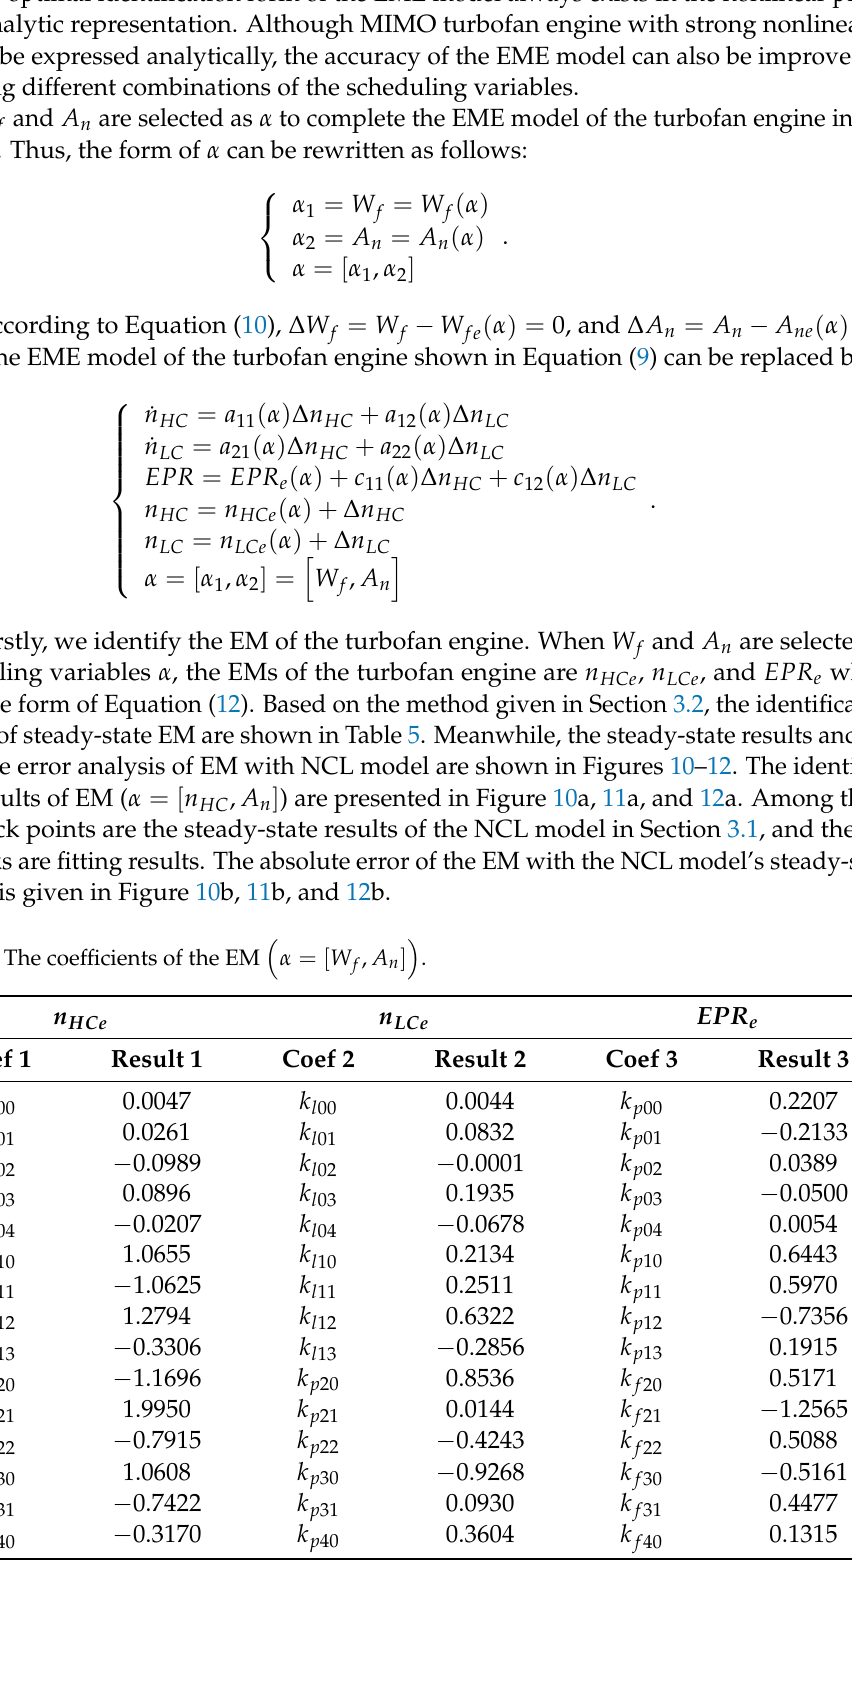
Table 5. The coefficients of the EM